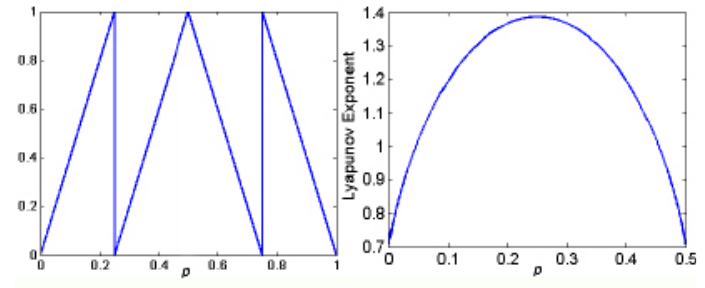
Figure 2. PWLCM plot and Lyapunov exponent [23].